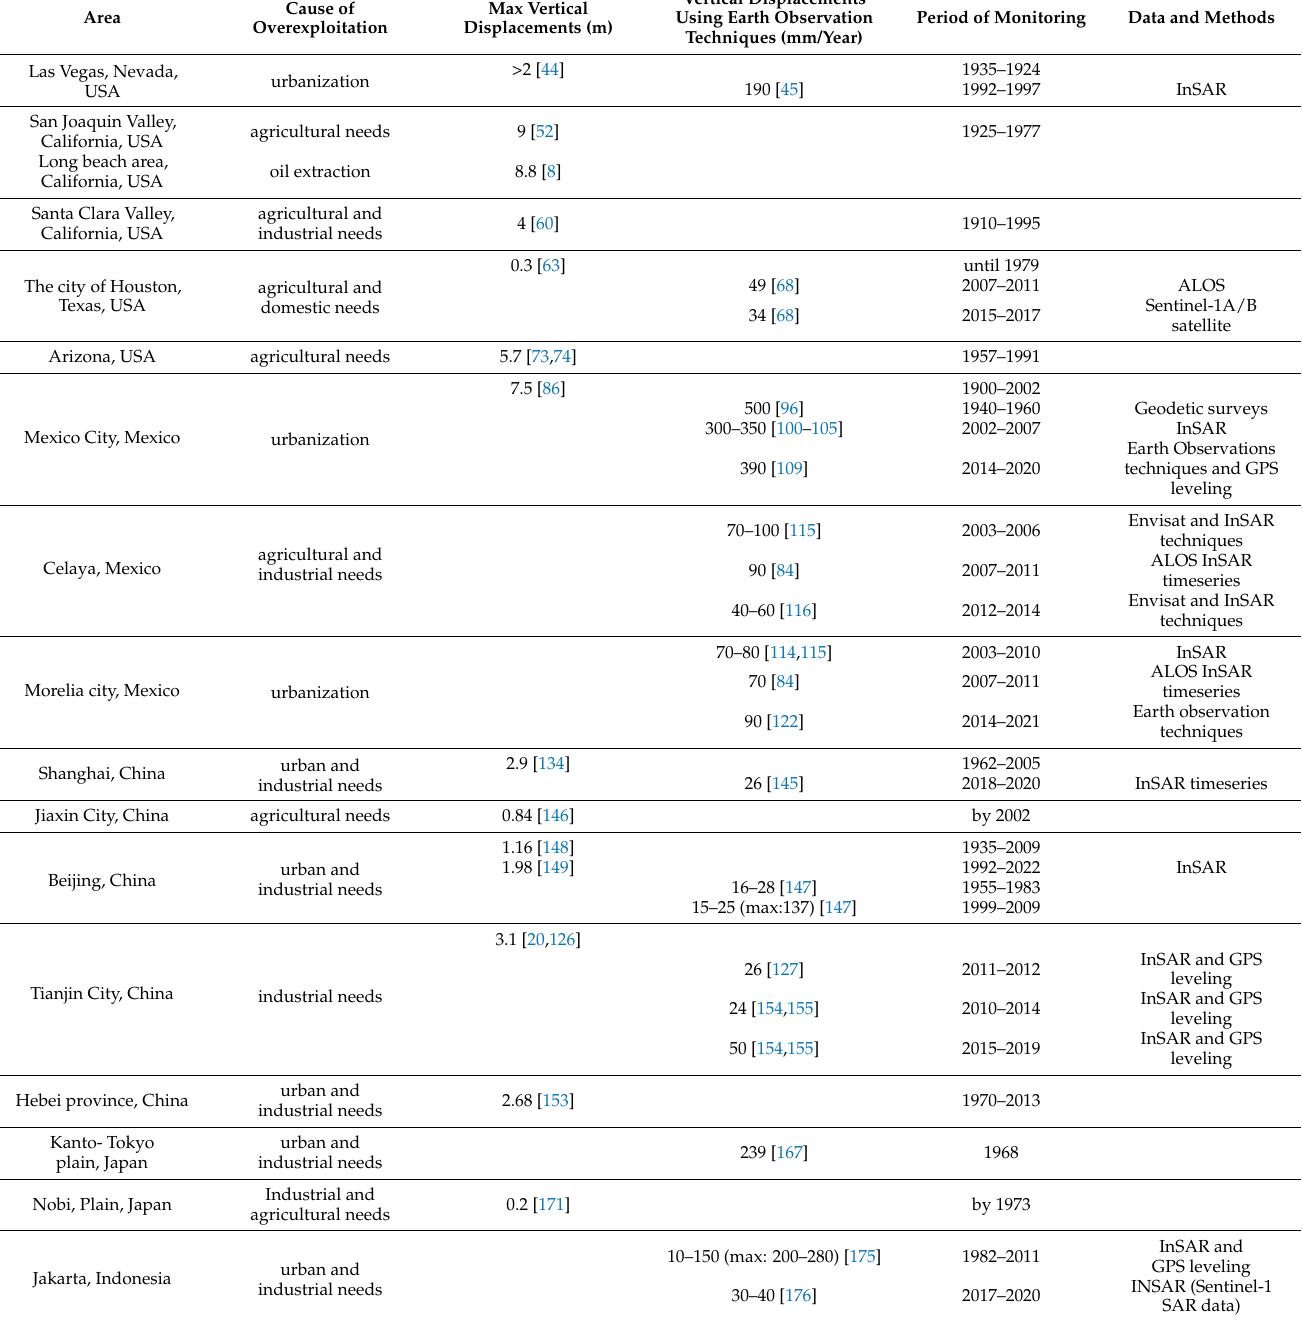
Table 1. Characteristic examples of land subsidence due to aquifer overexploitation worldwide since the early 20th